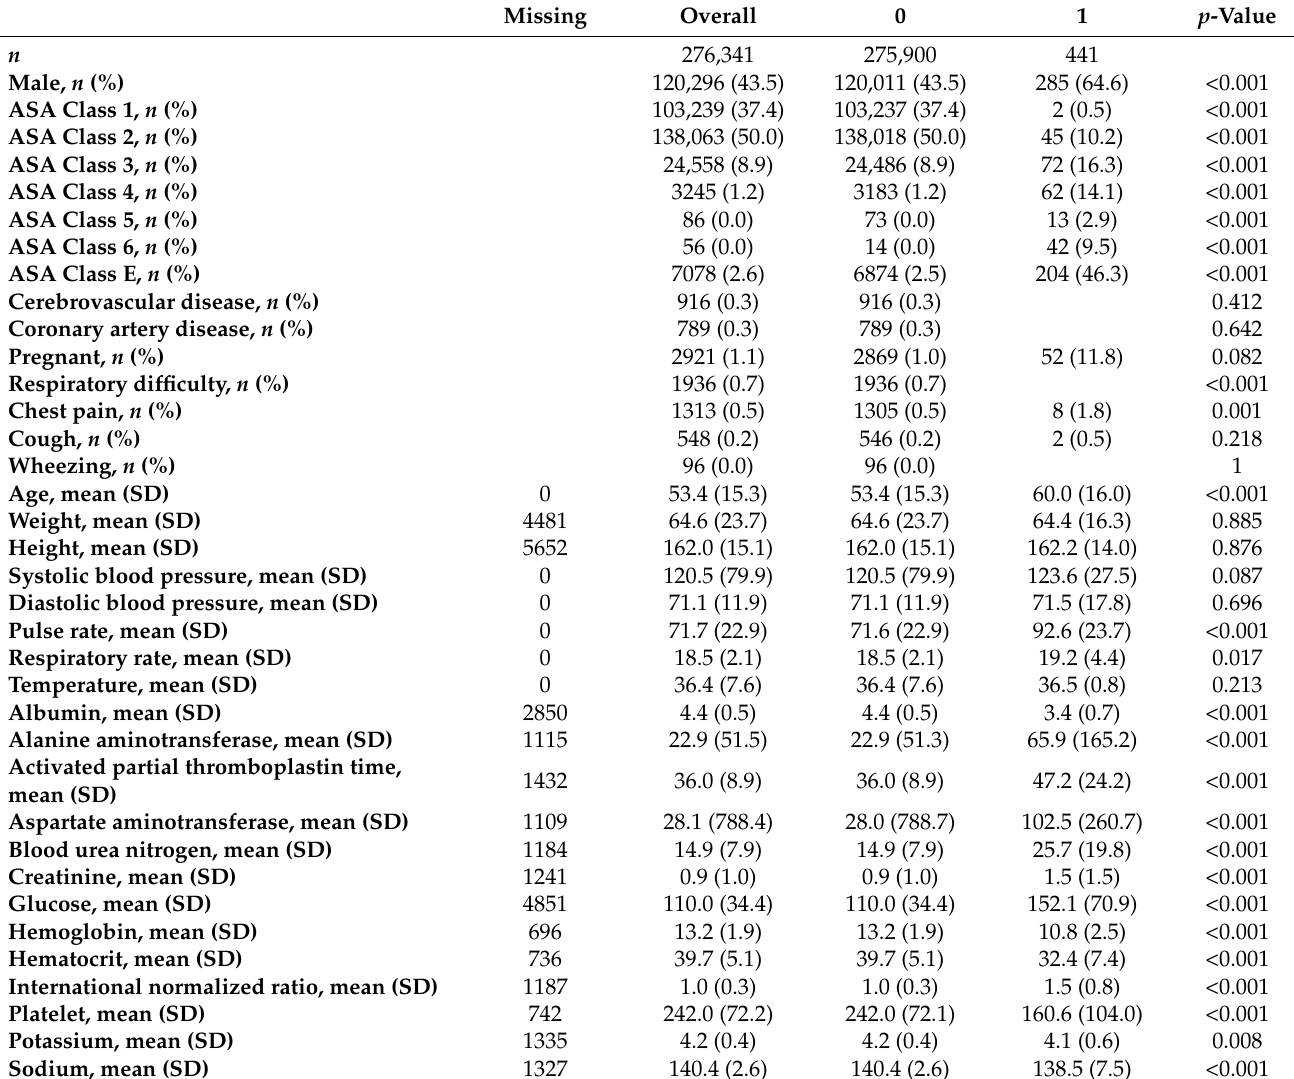
Table 2. Baseline characteristics of patients in the development